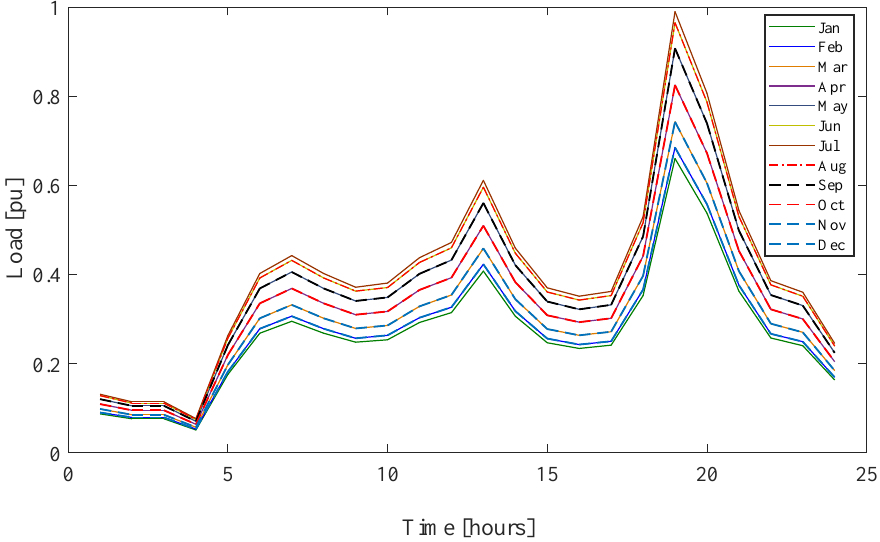
Figure 3. Daily load curve for weekends throughout the year.